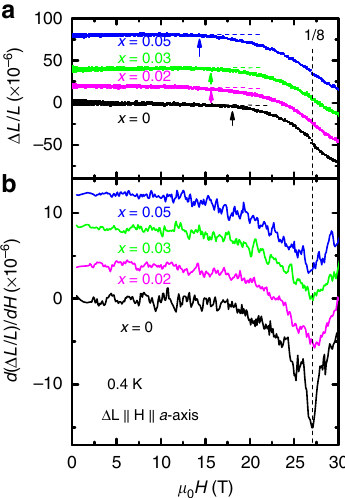
Fig. 4 Absence of the magnetization anomalies in magnetostriction measurements. Field dependence of a , relative deformation Δ L / L along the tetragonal axis, and b , its fi rst derivative d ( Δ L / L )/ dH , with Δ L ∥ H ∥ a -axis, at T = 0.4 K, for x = 0 (black), 0.02 (magenta), 0.03 (green), and 0.05 (blue). The arrows in a point to the onsets of deviation from linear fi ts to the low- fi eld regions for each doping (dashed lines). The vertical dashed line marks the (pseudo-) 1/8 plateau, identi fi ed as the local minima in d ( Δ L / L )/ dH vs. µ H . Traces are shifted for 0